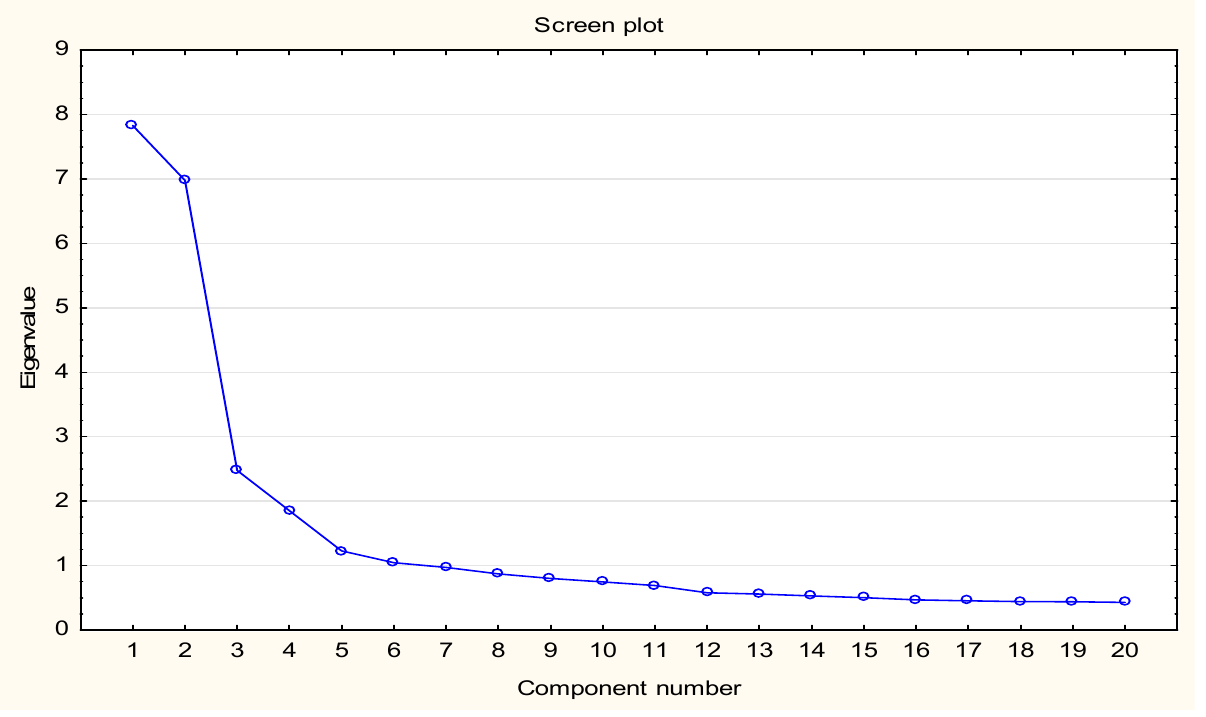
Table 2. Principal component factor analyses of the MAS-PL scale (Varimax rotation and Cronbach’s alpha).